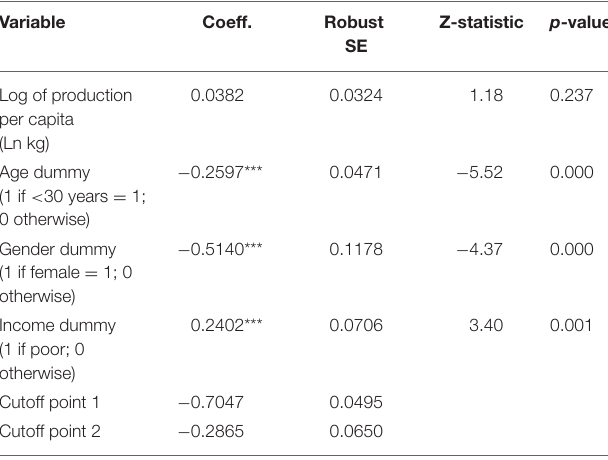
TABLE 8 | Frequency of consumption of millets and sorghum and production per state population: ordered probit regression. Variable Coeff. Robust